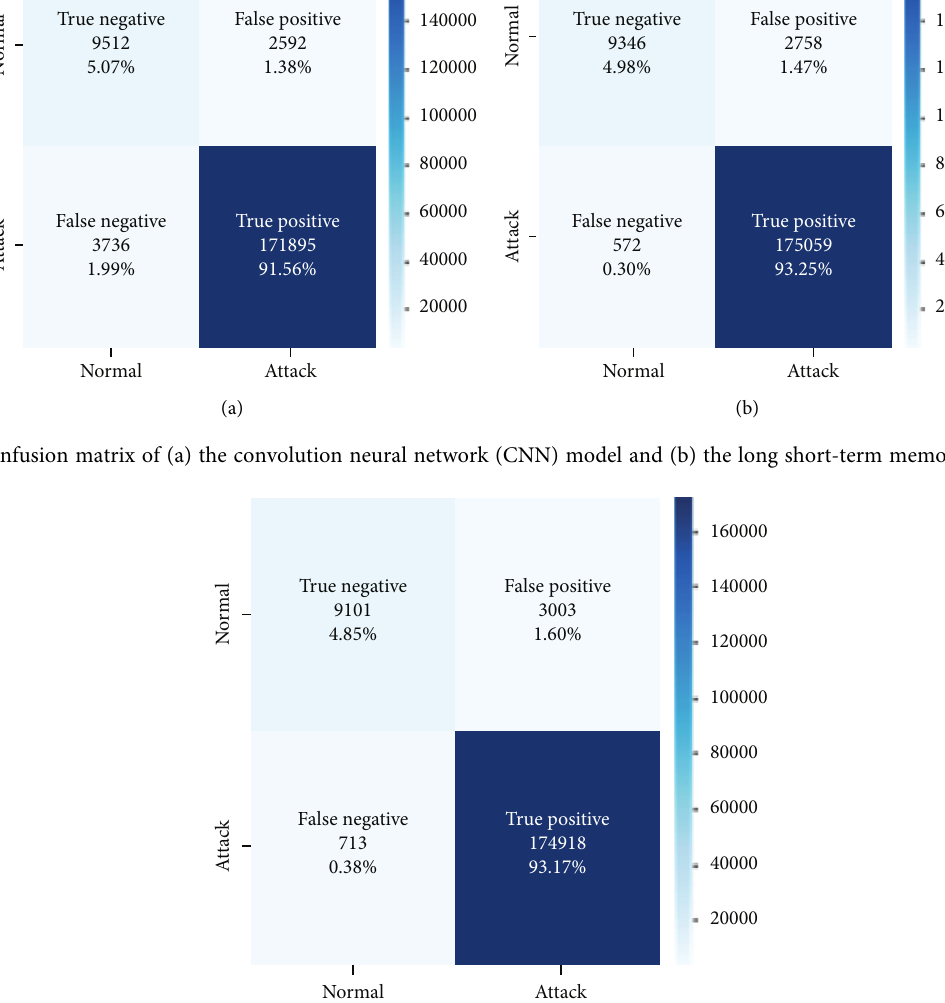
Figure 11: Confusion matrix of the convolution neural network long short-term memory (CNN-LSTM) model.